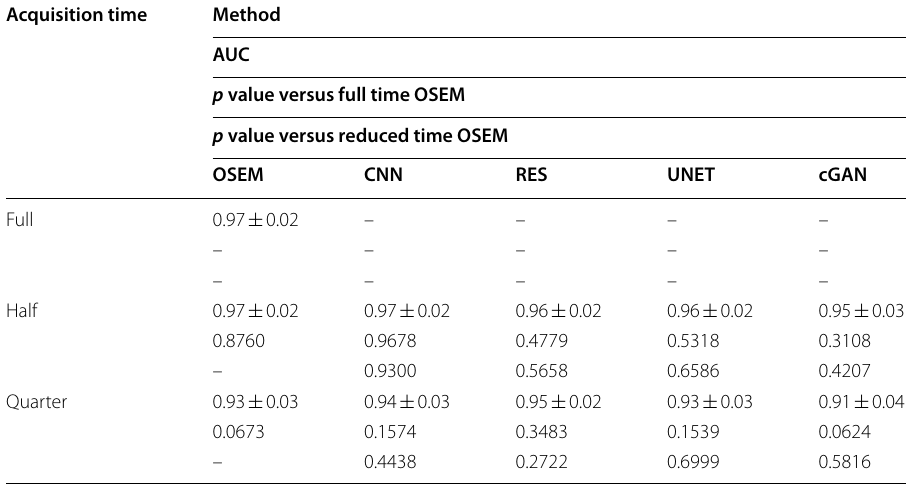
Table 5 Area under the ROC curve (AUC acquisition times at stress